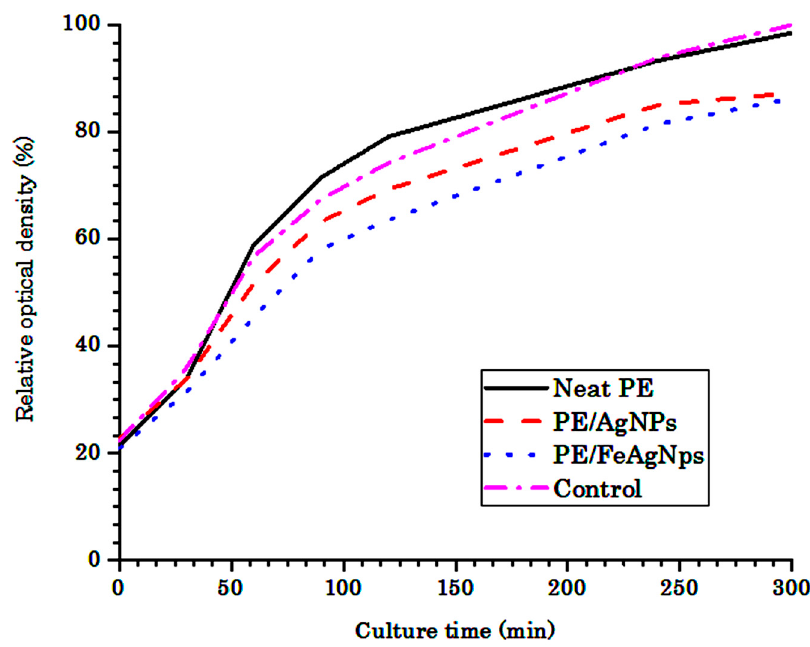
Figure 3. Growth rate of E. coli liquid cultures of neat PE and nanocomposites with Ag NPs and hybrid FeAg NPs. The data shown represent the average of three cultures (standard deviation < 2%). The control sample is a culture medium without PE.